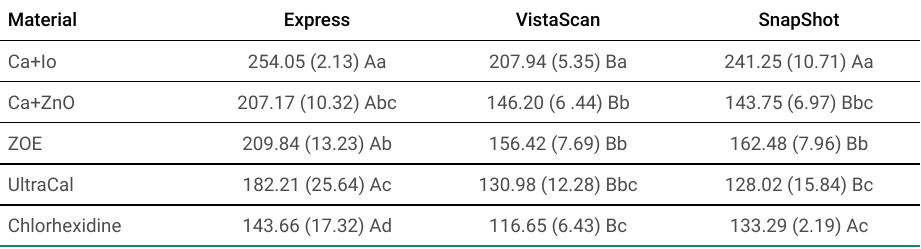
Table 1. Mean and standard deviation radioapacity values of the filling materials in the radiographic systems studied Material